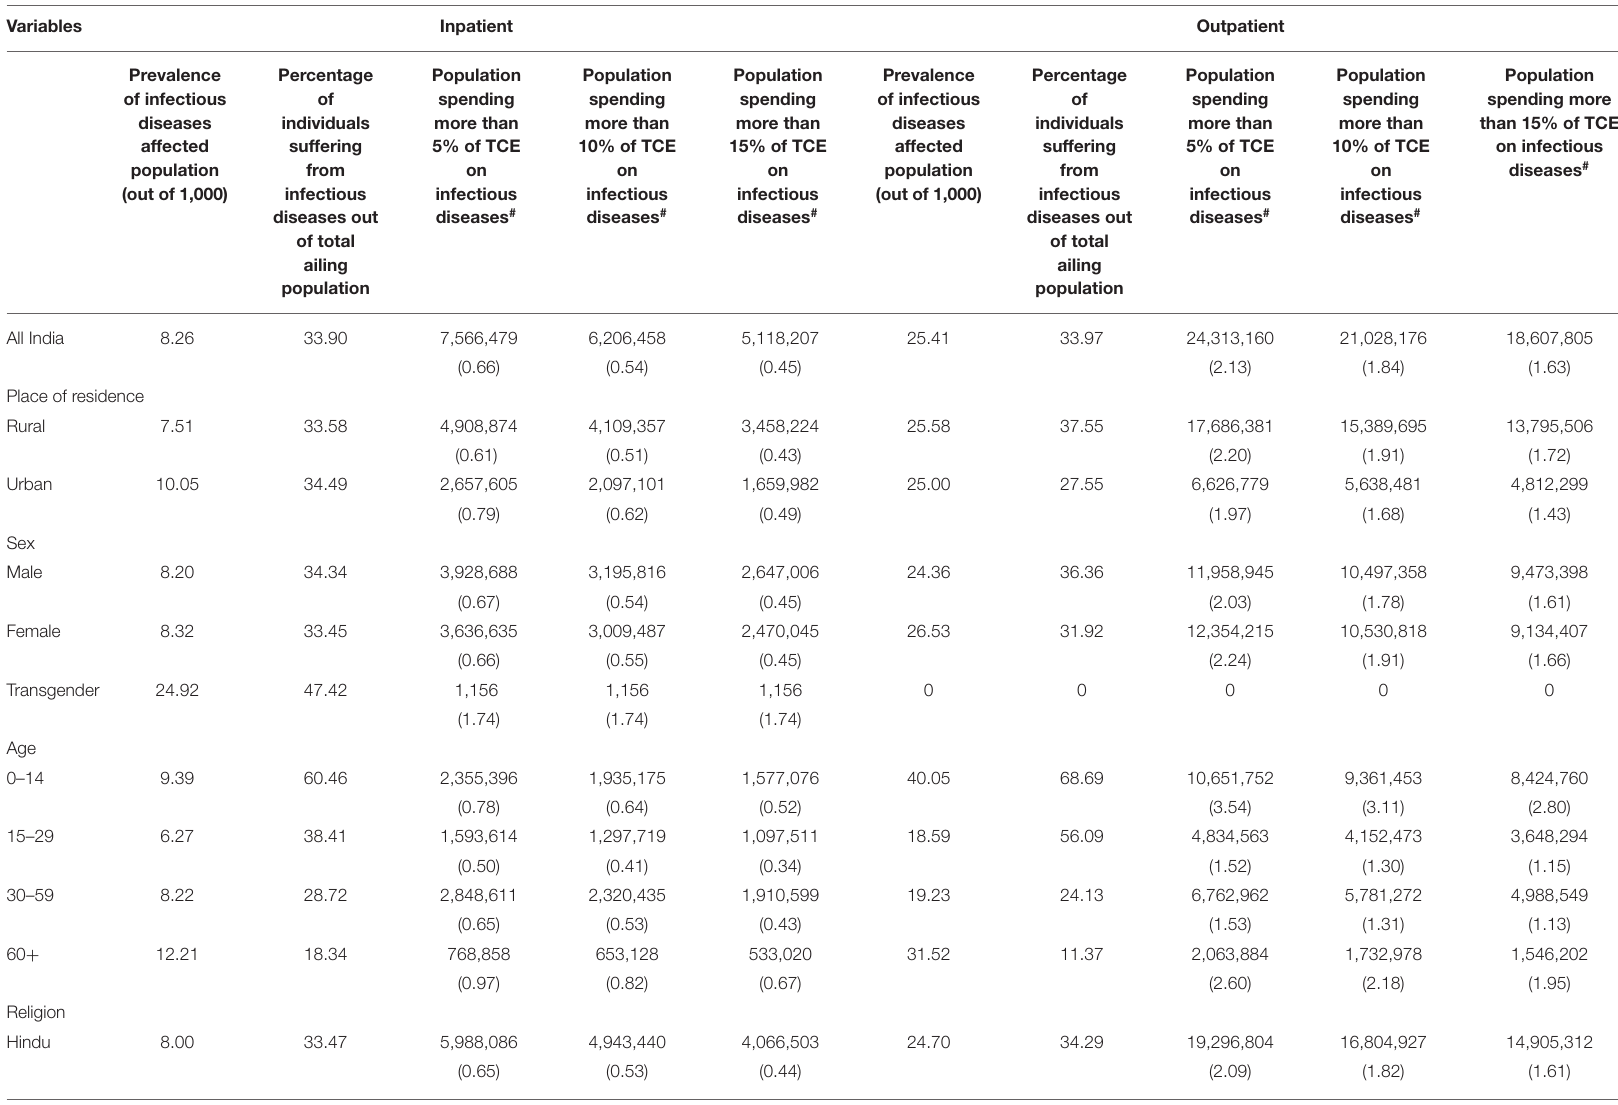
TABLE 2 | Socio-economic and demographic covariates in the prevalence rate (out of 1,000), and the population spending OOP as a percentage of total consumption expenditure (TCE) on infectious diseases at various thresholds levels in India (2017–18). Variables Inpatient